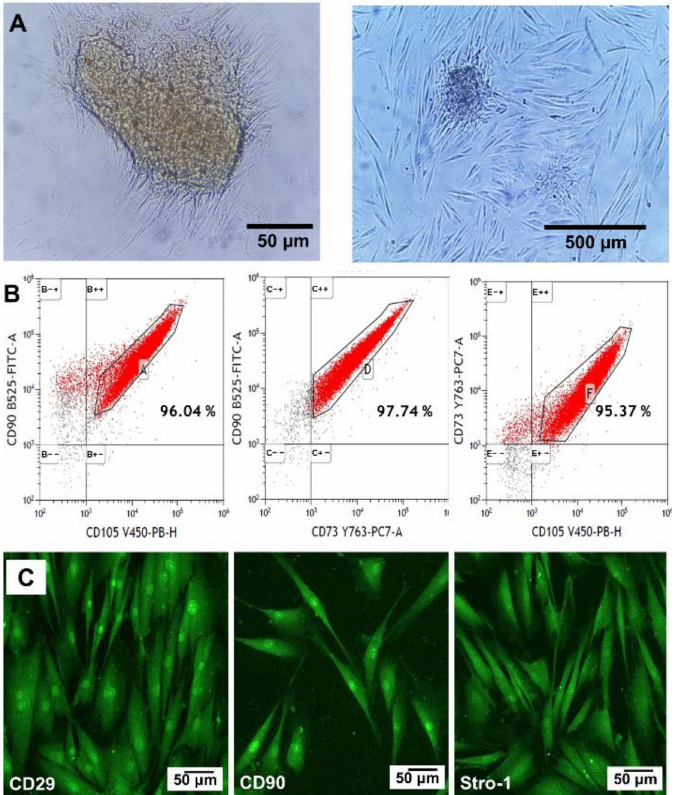
Figure 8. Characterization of human oral mucosa stem cells (hOMSCs). ( A ) Optical microscope images of the cells isolated from tissue explant after 14 days of culture. ( B ) Flow cytometry profiles and percentage of cells expressing CD90, CD105 and CD73, among the population of cells. ( C ) Fluorescence microscopy of selected mesenchymal stem cell markers (CD29, CD90 and